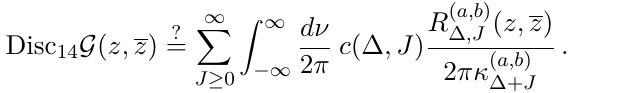
Figure 7 . Similar to figure 4: the Sommerfeld-Watson transform for the F ( a,b )good contour should remain to the right of singularities of c t,u . The contours are equivalent in Euclidean kinematics, and the second one allows a safe continuation to